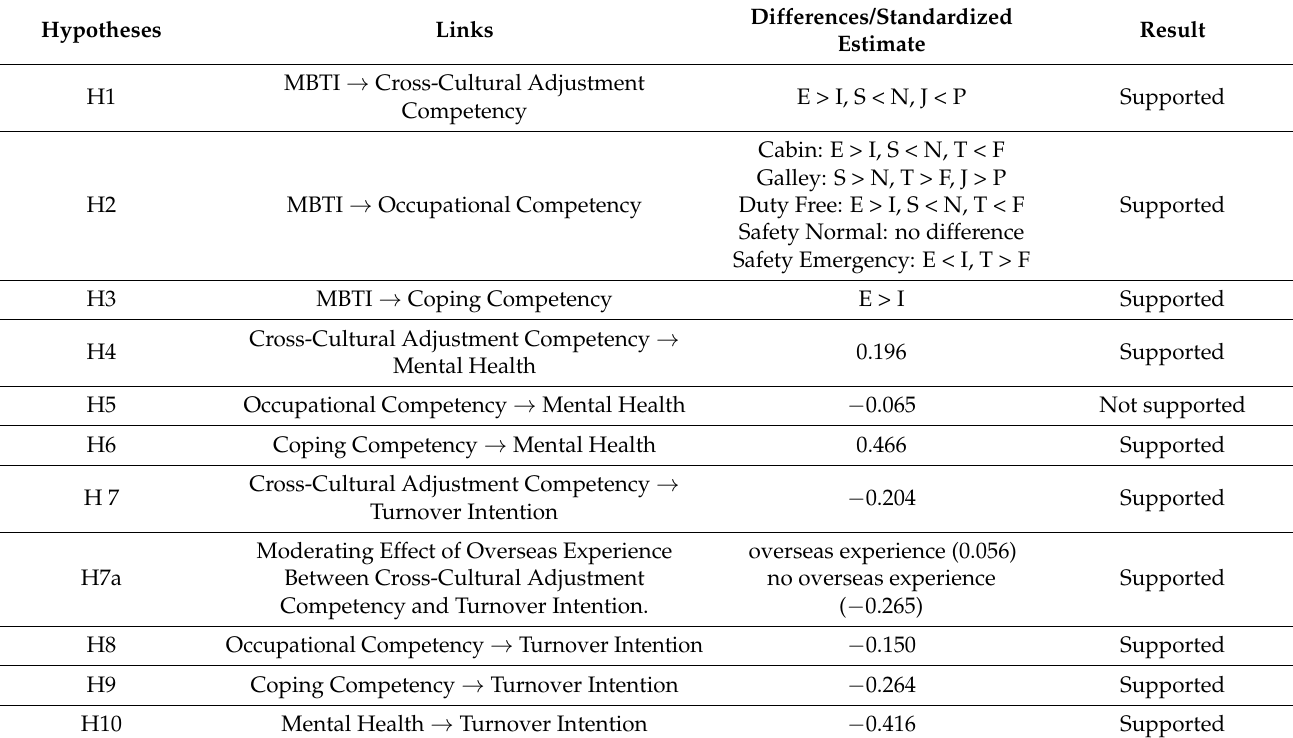
Table 6. Hypothesis